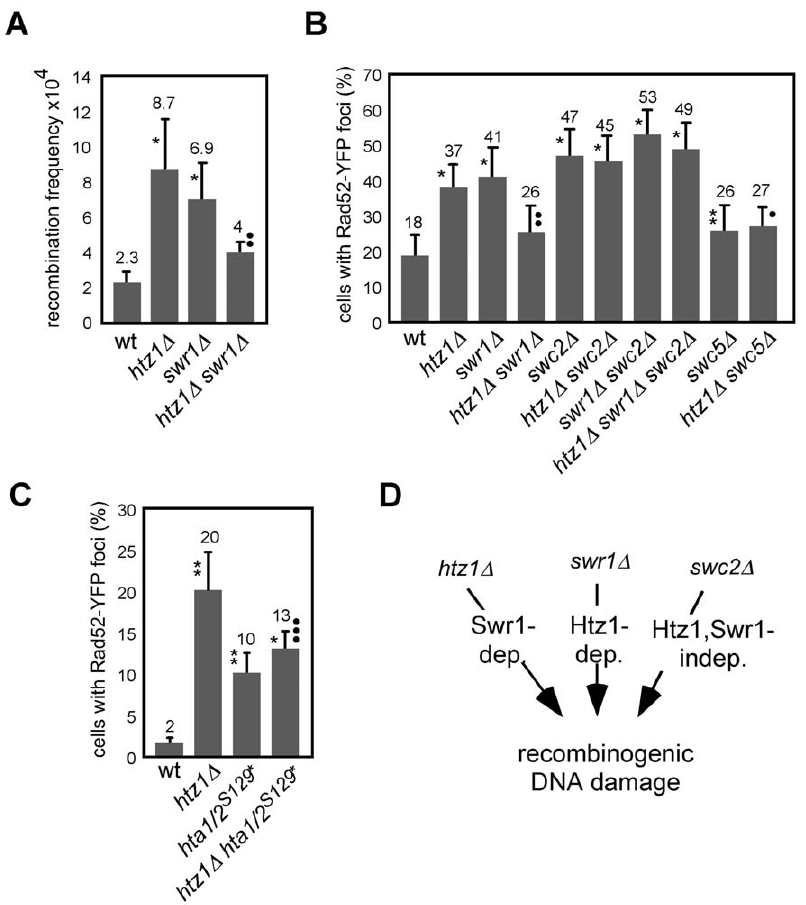
Figure 1. The SWR1 complex causes genetic instability in the absence of Htz1. ( A ) Effect of htz1 D , swr1 D and htz1 D swr1 D (BY4741) on the frequency of inverted-repeat recombination. ( B ) Effect of htz1 D , swr1 D , swc2 D , swc5 D , htz1 D swr1 D , htz1 D swc2 D , htz1 D swc5 D , swr1 D swc2 D and htz1 D swr1 D swc2 D (BY4741) on the frequency of budded cells with Rad52-YFP foci. ( C ) Effect of htz1 D , hta1/2 S129* and htz1 D hta1/2 S129* (W303-1a) on the frequency of budded cells with Rad52-YFP foci. ( D ) Scheme with the pathways of accumulation of recombinogenic DNA damage in htz1 D , swr1 D and swc2 D . The frequency of recombination and budded cells with Rad52-YFP foci is presented as the average and standard deviation as described in Materials and Methods. Asterisks and circles indicate statistically significant differences compared to wild type and htz1 D , respectively, according to a Student’s t -test, where one asterisk/circle represents a P -value , 0.0001, two represents , 0.005, and three represents , 0.025.